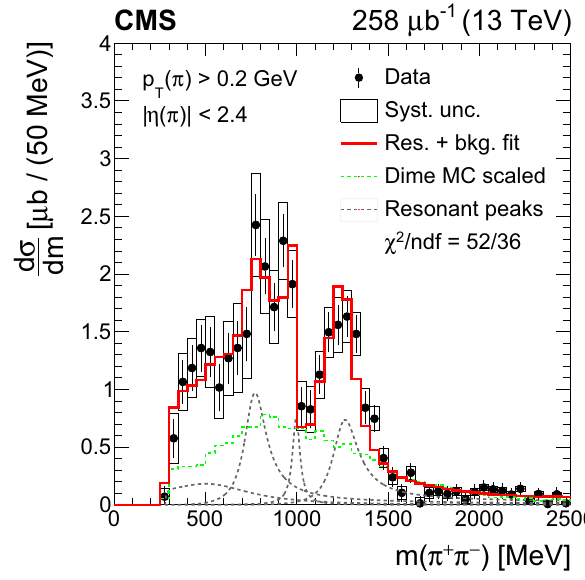
Fig. 6 Fittothemeasuredcrosssectionwiththesumoffourinterfering relativistic Breit–Wigner functions convolved with a normal distribu- tion (to account for the the experimental resolution of the detector) for